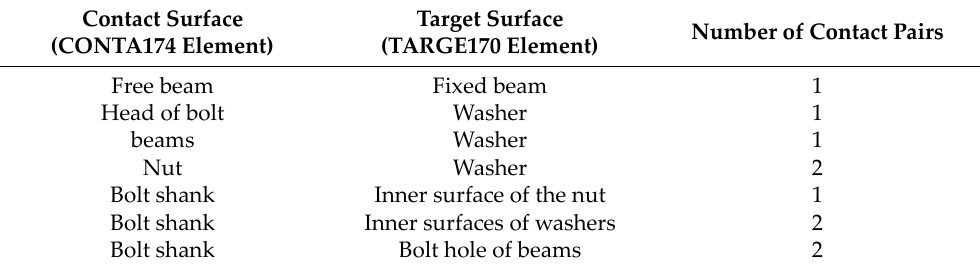
Table 1. Definition of contact pairs.